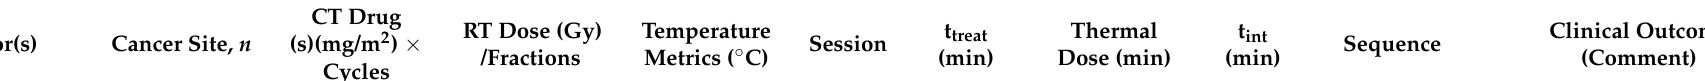
Table 12. Retrospective clinical studies using RT and CT in combination with